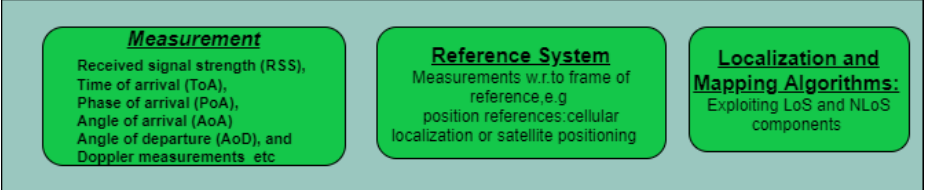
Figure 5. Components of a localization and the mapping